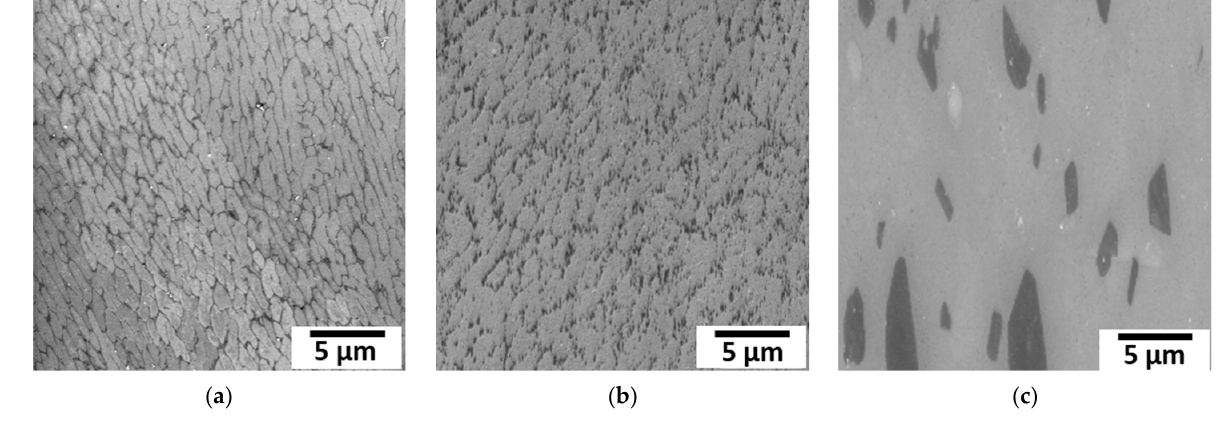
Figure 3. SEM images of PBF-LB/M AlSi10Mg: ( a ) AB, ( b ) HT1, and ( c ) HT2 conditions.